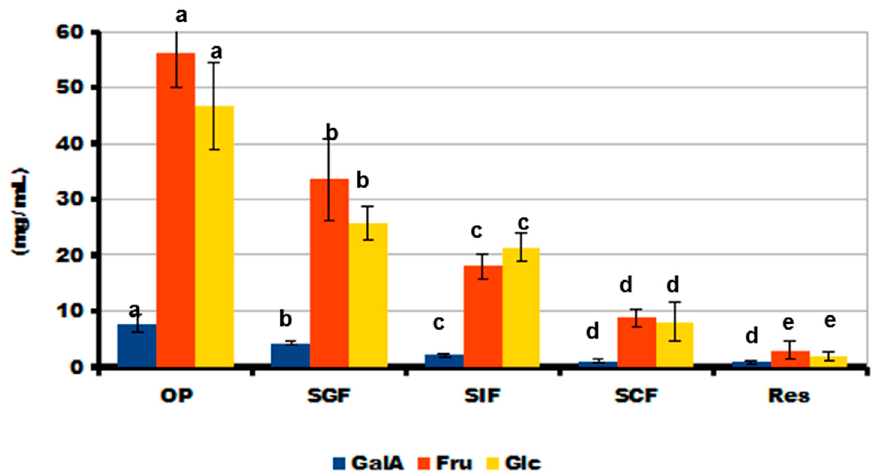
Figure 10. The amount of galacturonic acid (GalA), fructose (Fru), and glucose (Glc) released from LA16-33 gel during successive oral in vivo (OP) and gastrointestinal in vitro phases of digestion. SGF, SIF, and SCF—simulated gastric, intestinal, and colonic fluids, respectively. The data are presented as the mean ± SD. Different lowercase letters indicate significant differences among means for the different phases of digestion of each sugar ( n = 6, p < 0.05).